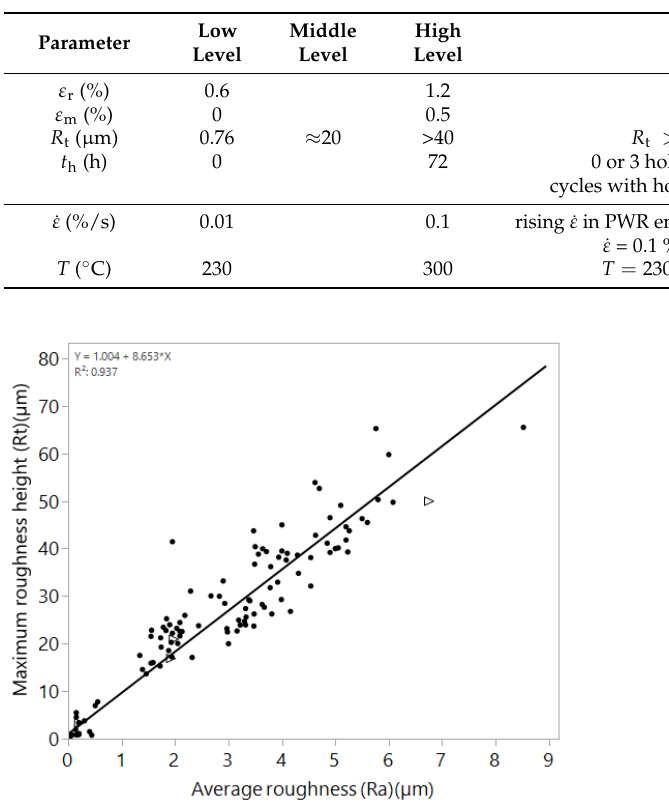
Table 2. Test conditions in the main programme and the sub-programme on low F en testing.